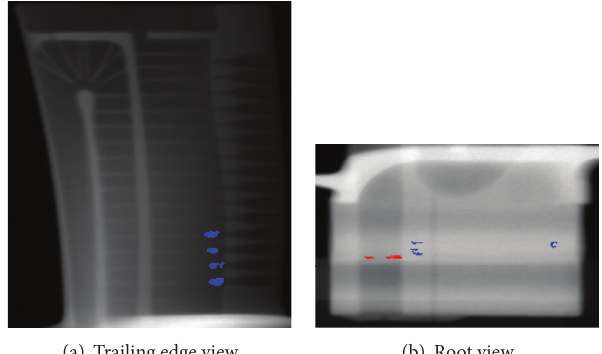
Figure 2: Callout images of ADR with markings for blade type A. The blue marking represents less material, and the red represents excess material.